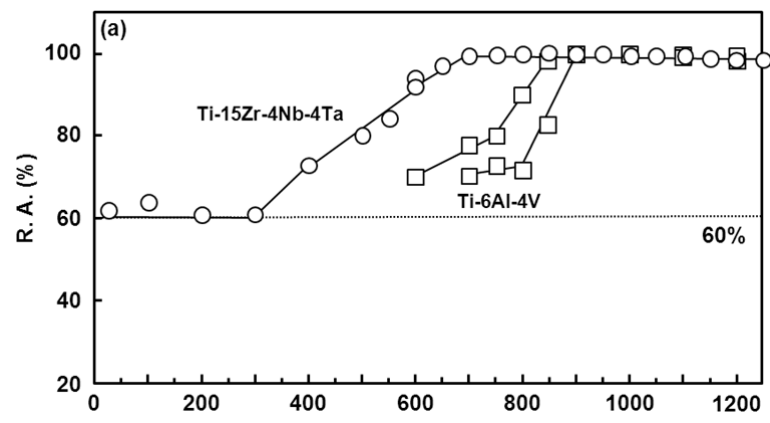
Figure 18. Comparison of R.A. of Ti-15Zr-4Nb-4Ta (B) and Ti-6Al-4V alloys obtained by high-temperature tensile test. ( a ) Effect of test temperature on R.A.; ( b ) effect of temperature difference ( Δ T) between T β and test temperature of tensile test on